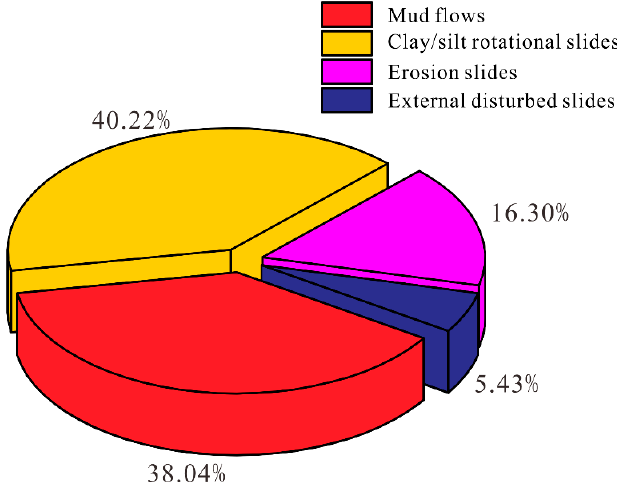
Figure 6. Statistics of the proportions of landslide types on the South Jingyang Plateau.